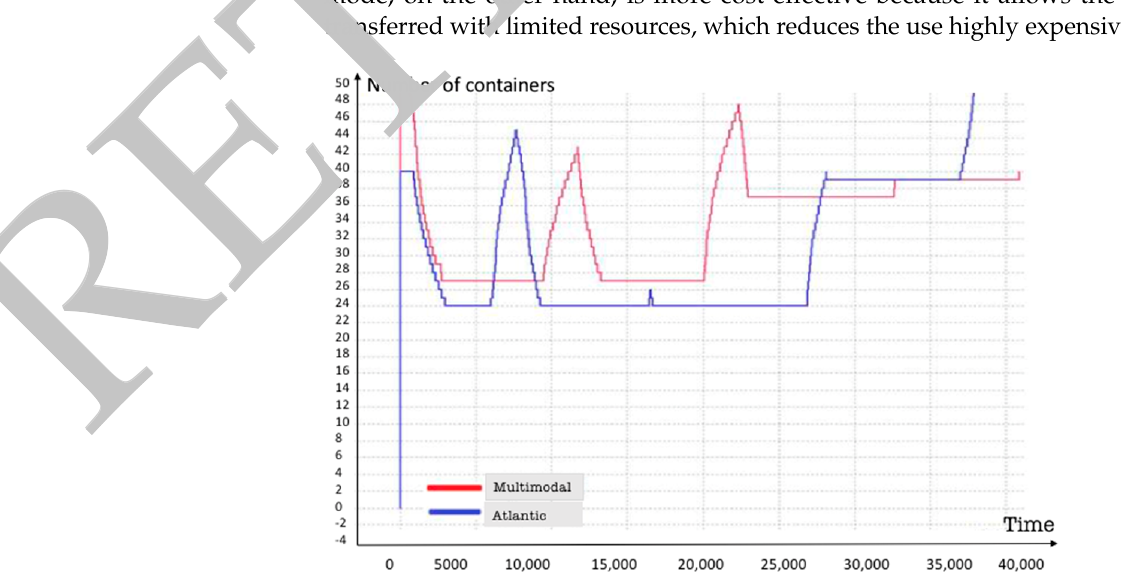
Figure 8. Circulation in optimized transfer mode.